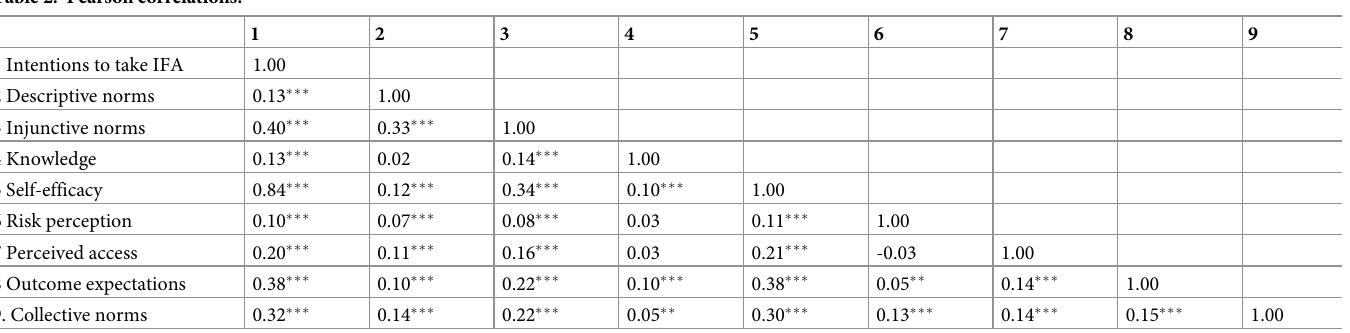
Table 2. Pearson correlations.